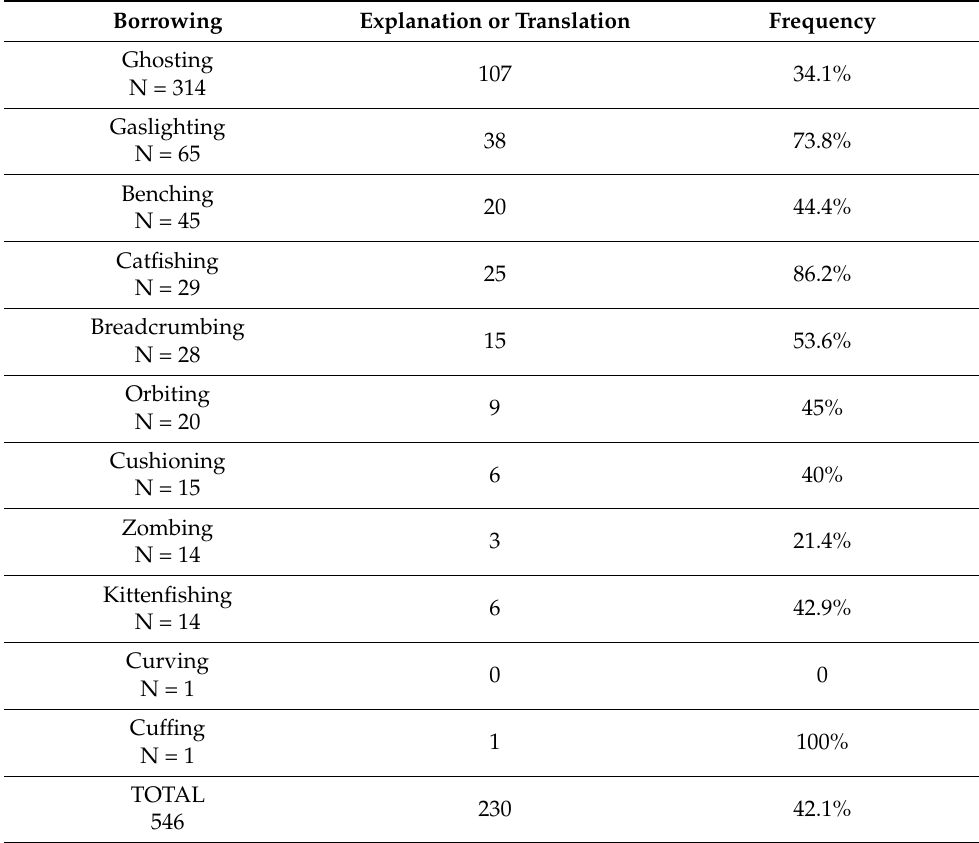
Table 3. Data regarding the presence of explanations or translations of the borrowings in the analyzed